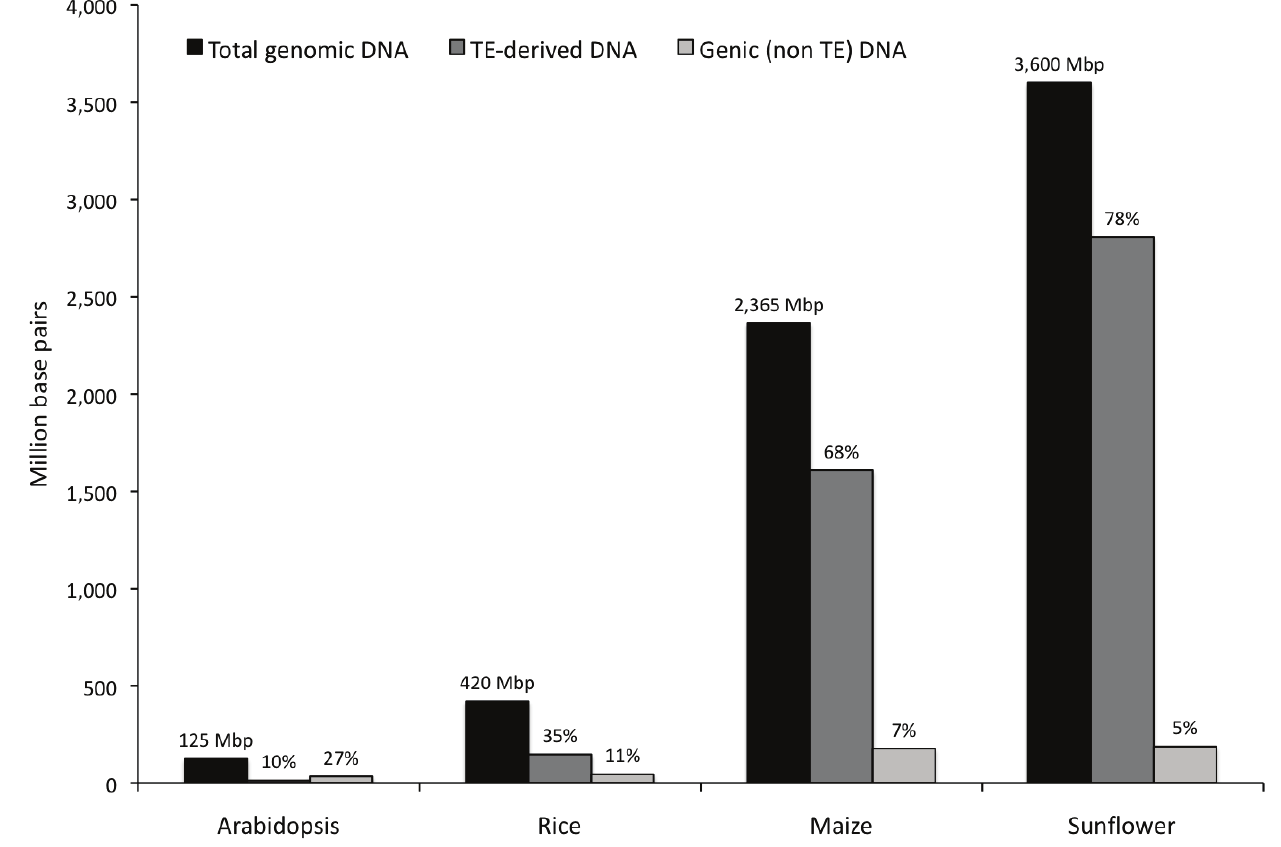
Figure 4. Comparison of the genome size, TE-derived and genic DNA (non TE-derived) among Arabidopsis , Rice, Maize and Sunflower [26 –